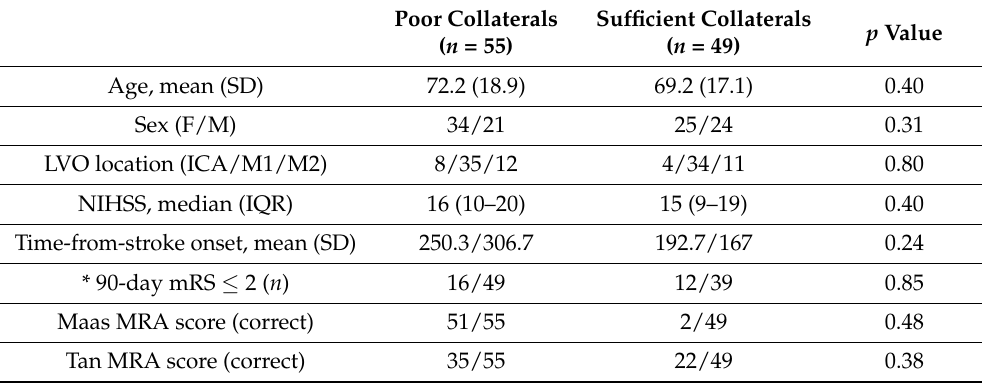
Table 2. Demographic data of patients with poor and sufficient collaterals as defined by DSA.